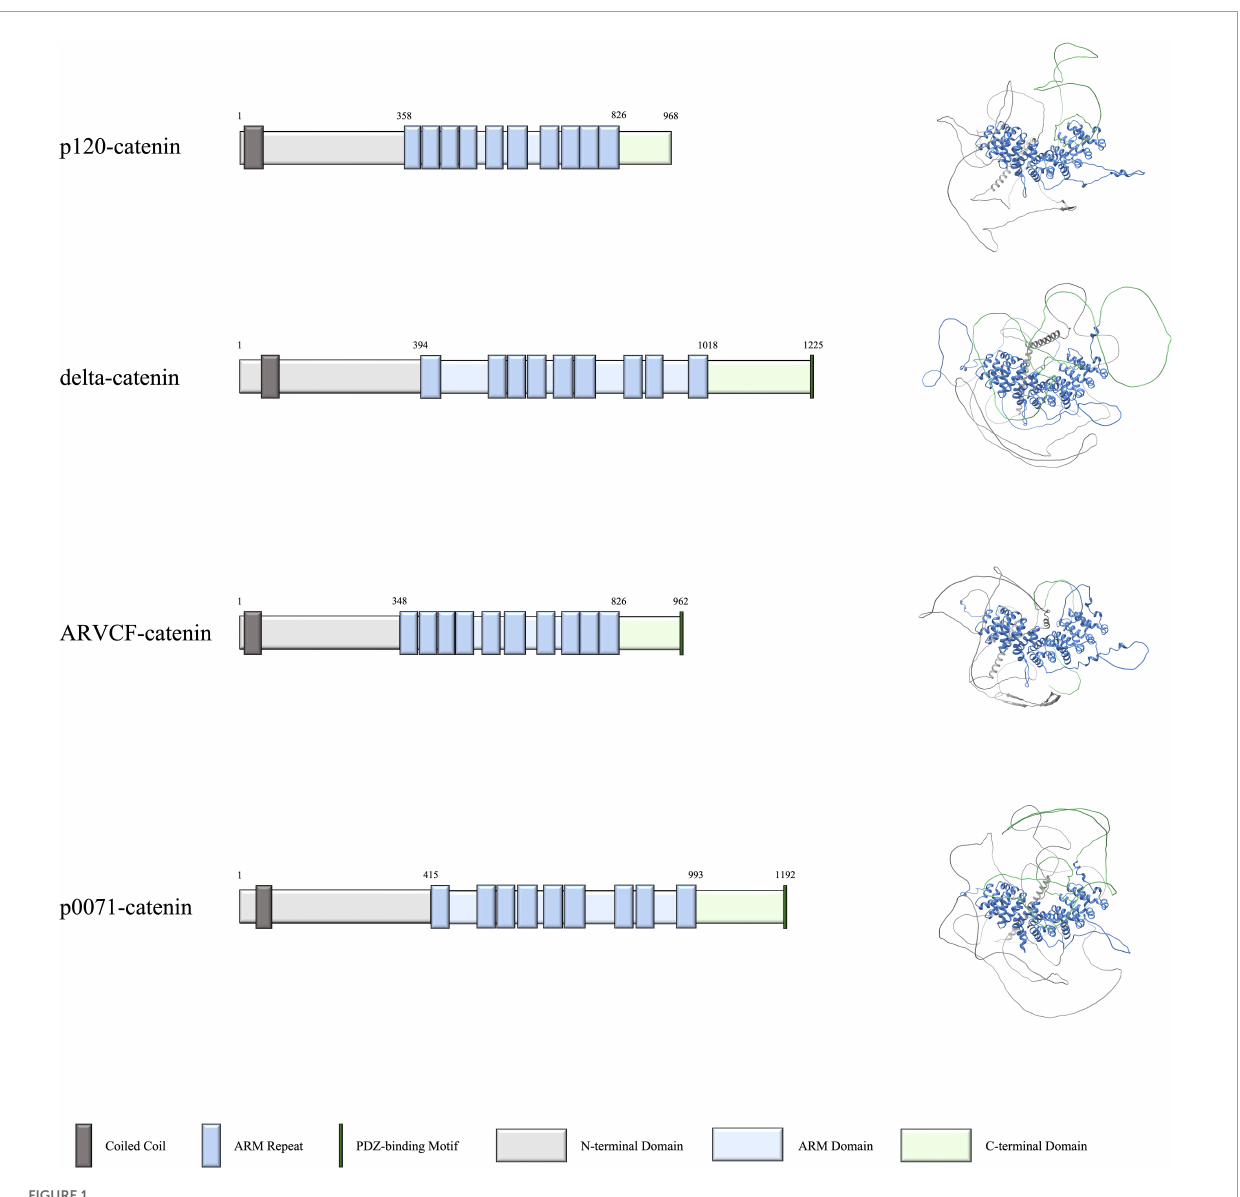
FIGURE1 Domains and structures of human p120-catenin subfamily proteins. Schematics on the left depict the domains of p120-catenin, delta-catenin, ARVCF-catenin, and p0071-catenin, with the corresponding predicted structure of each protein on the right. Data for domain schematics was obtained from UniProt, and models were made using AlphaFold (The UniProt Consortium, 2018; Jumper et al.,